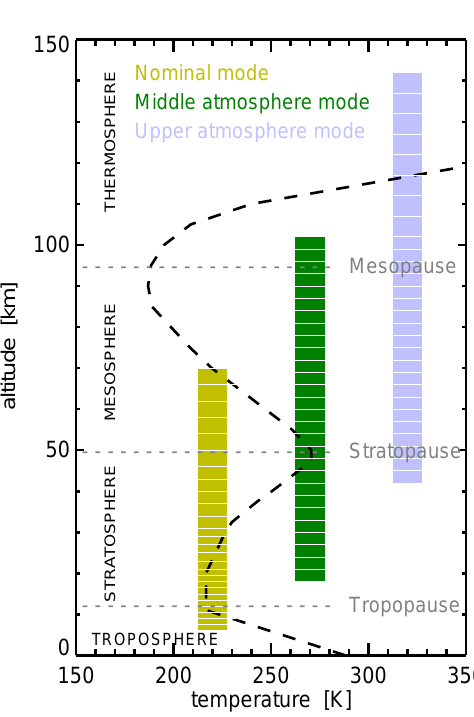
Fig. 14. MIPAS optimised resolution operation measurement modes.